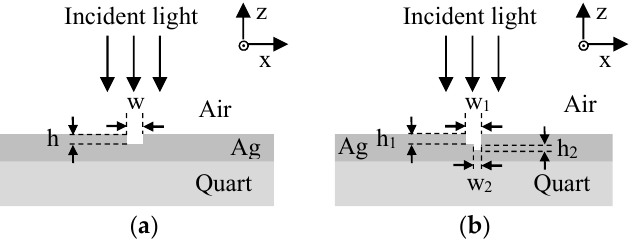
Figure 2. Schematic view of ( a ) 2D symmetric MIM slot and ( b ) 2D asymmetric slot with a primary MIM slot and an auxiliary cavity.